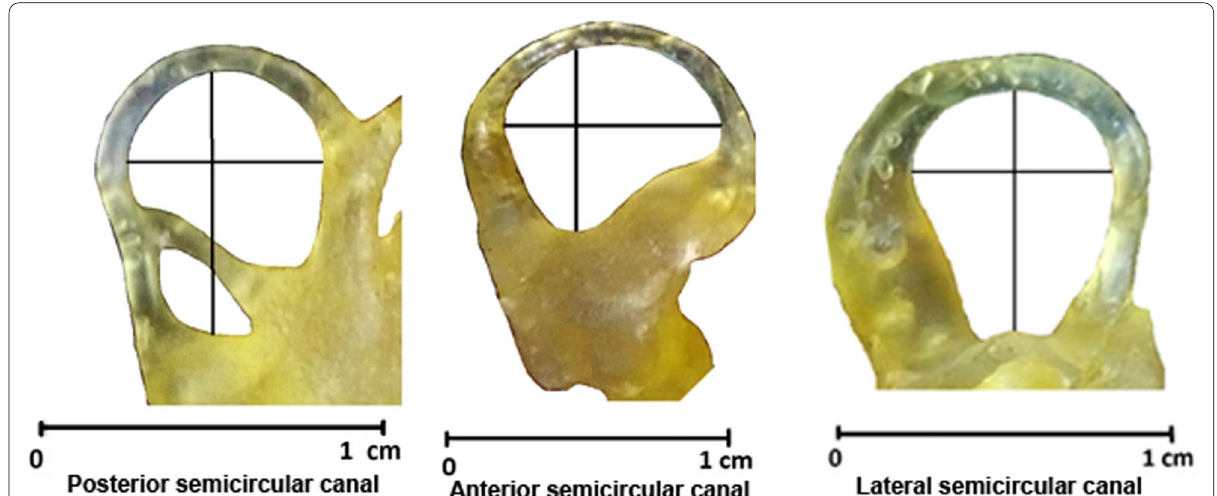
Fig. 3 Endocast with drawn lines showing how the measurements for the calculation of radius of curvature of each semicircular canal were taken. The radius of curvature of each semicircular canal is calculated as half the average between the height and width of the canal arc